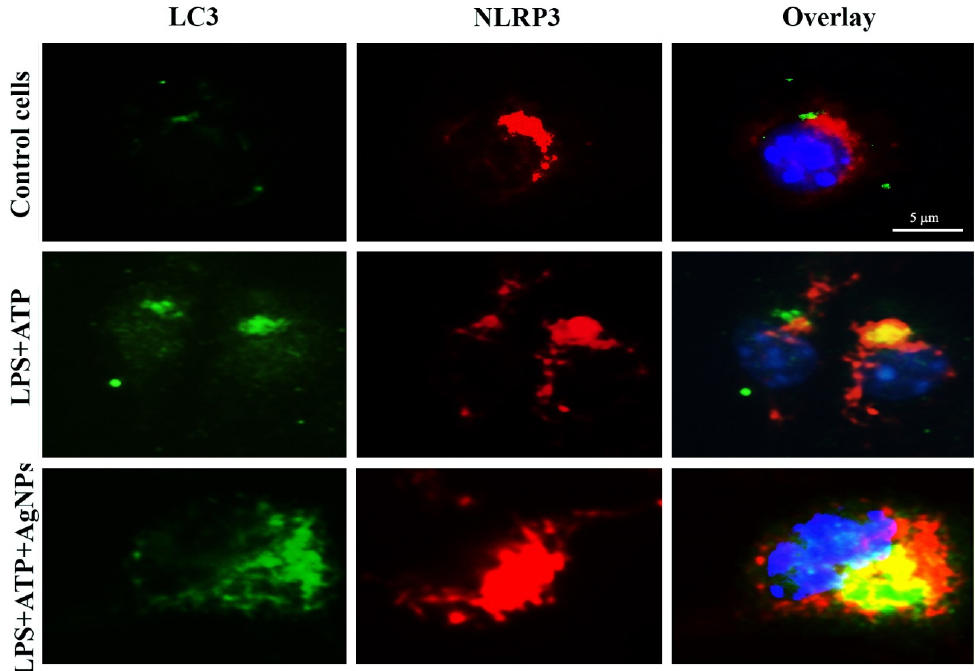
Figure 12. AgNPs increase the targeting of NLRP3 by autophagy. Confocal images of LC3 in BMDMs (green): Cells were left untreated as a control or treated with LPS+, with and without treatment with 5 µ gmL − 1 AgNPs. Staining of BMDMs was with anti-NLRP3 antibody (red) and staining of nuclei was with DAPI. Co-localization of the LC3 and NLRP3 staining reveals the merged LC3 and NLRP3 signals; co-localized regions appear in yellow. Scale bar, 5